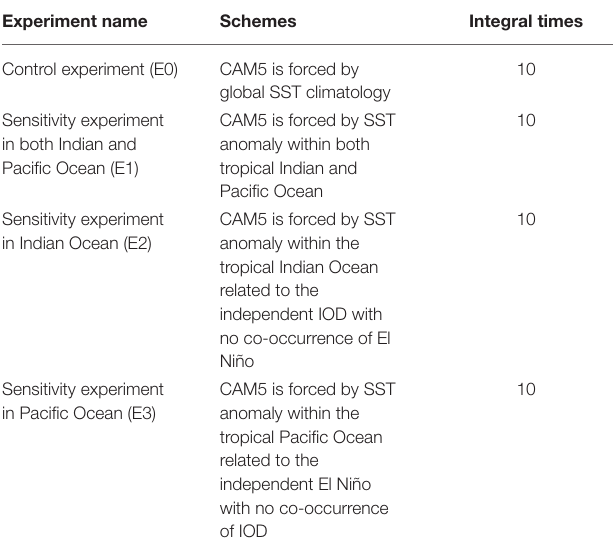
TABLE 4 | Schemes of the four CAM5